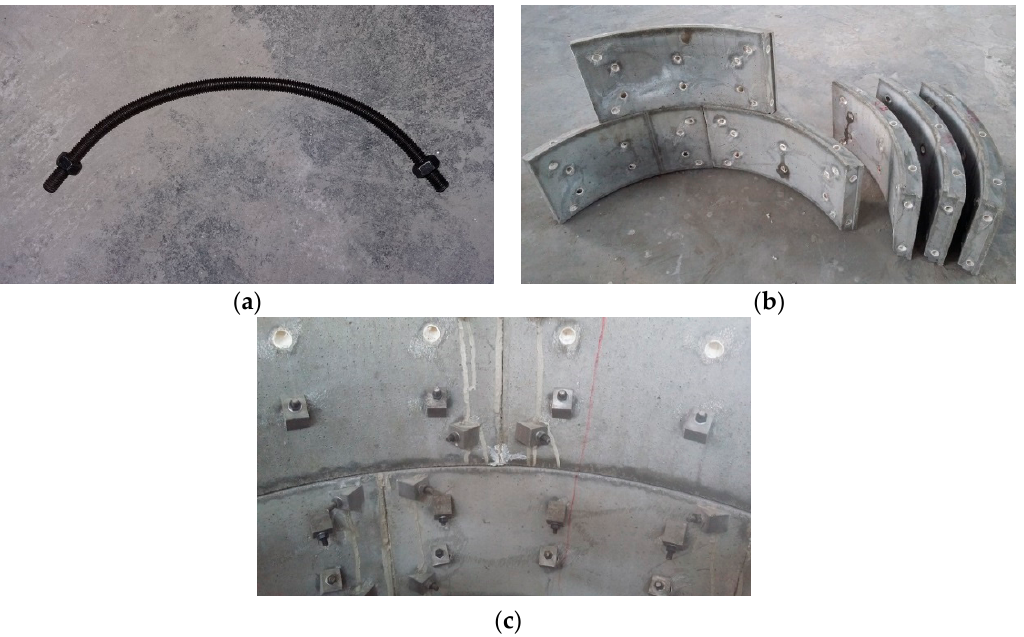
Figure 11. Images showing the components of the scaled-down model. ( a ) Bent screw; ( b ) Concrete segment; ( c ) Longitudinal and circumferential joints.